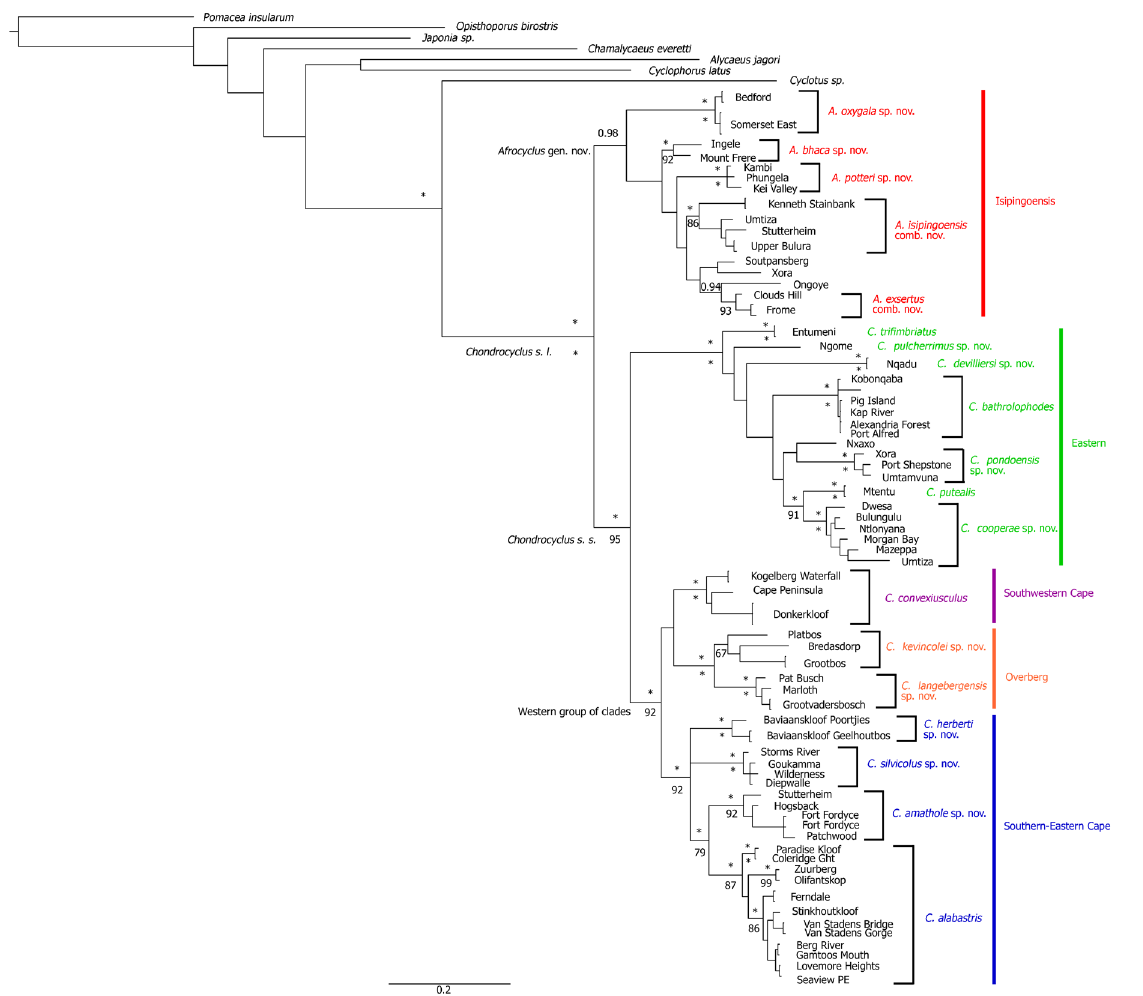
Fig. 1. Bayesian Inference majority consensus tree of the “taxa complete” concatenated CO1-16S sequence dataset for Chondrocyclus s.l. Ancey, 1898 (84 sequences) and seven other caenogastropods with the tree rooted on Pomacea insularum (d’Orbigny, 1837) (modified from Cole et al. 2019). Colours indicate major clades of Chondrocyclus Ancey, 1898 and correspond with colours used in maps. Support values are given as posterior probabilities for Bayesian analysis above nodes (only values ≥ 0.95 are shown) and as bootstrap percentages for ML analysis below nodes (only values ≥ 65% are shown); maximal support (Bayesian = 1, ML = 100%) is indicated by an asterisk. Scale bar indicates substitutions per